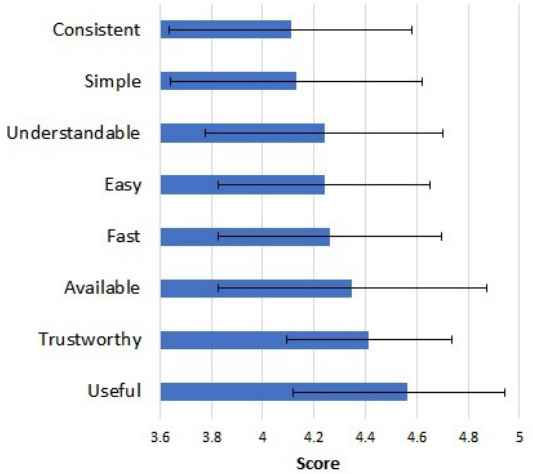
Figure 7. Average scores obtained for each